Question: What visual encoding does this figure use to show its data?
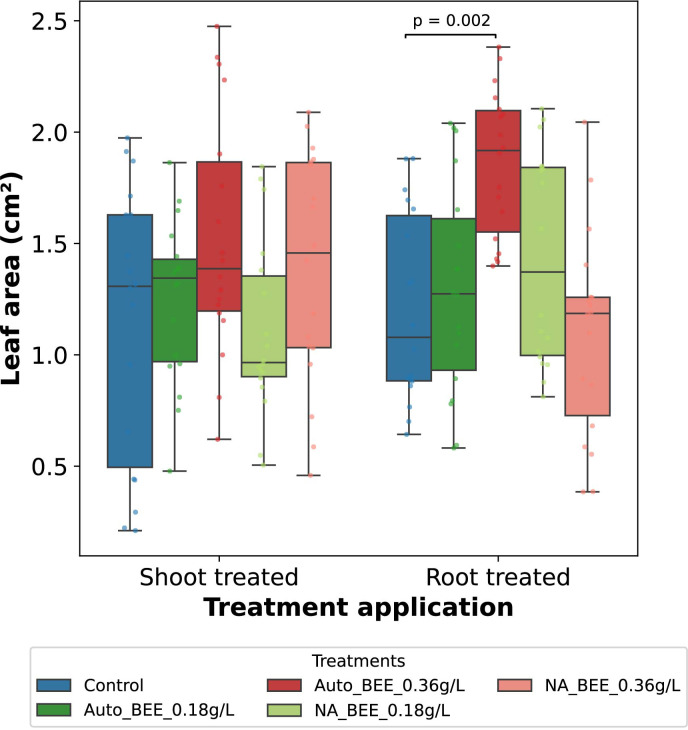
Answer: box